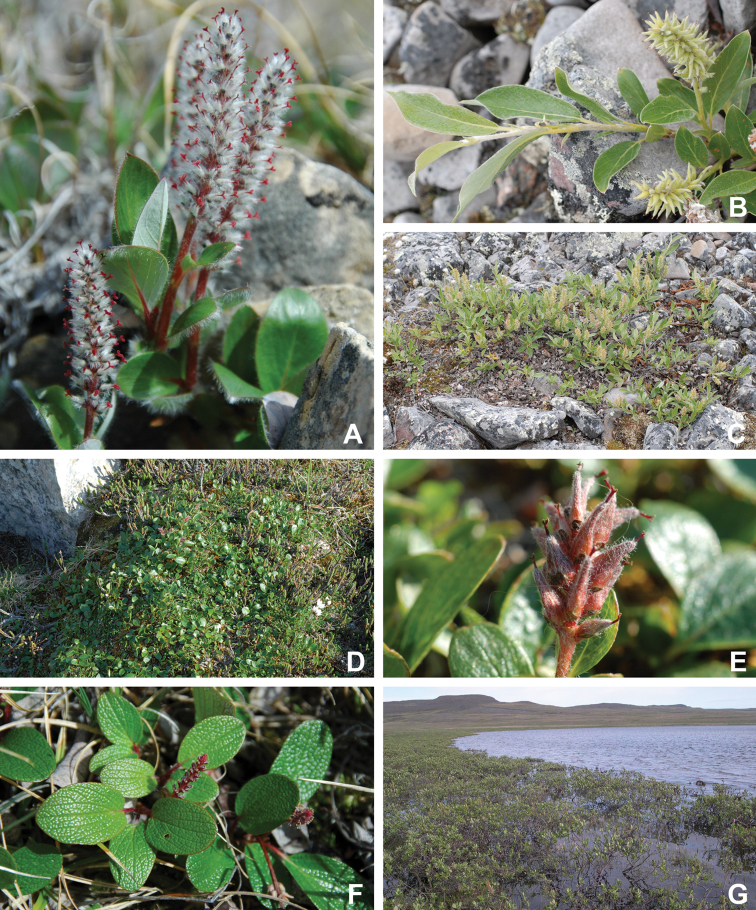
ASalix
arctica pistillate catkins, Gillespie et al. 7484BSalix
glauca
var.
stipulata pistillate catkins, Gillespie et al. 8038CSalix
glauca
var.
stipulata habit, Gillespie et al. 8038DSalix
polaris habit, Gillespie et al. 9991ESalix
polaris pistillate catkins, Gillespie et al. 9991FSalix
reticulata habit, Gillespie et al. 7475GSalix
richardsonii habitat, Johansen Bay, NU, 15 July 2008. Photos A, F by R.D. Bull and B, C–E, G by L.J. Gillespie.